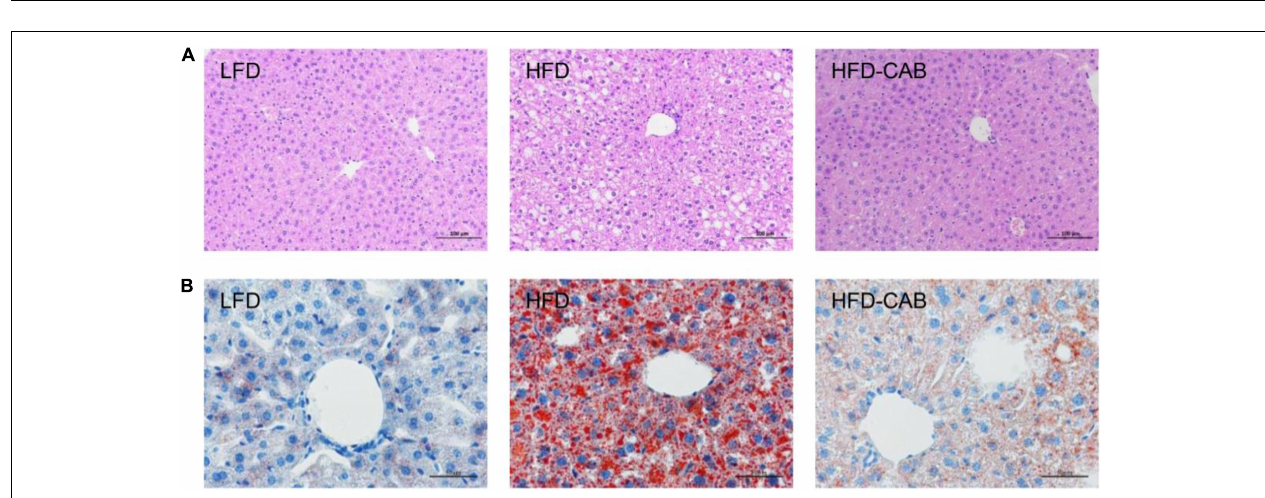
FIGURE 2 | Cooked adzuki bean alleviates dyslipidemia and liver injury in HFD-fed mice. (A) Serum lipid profile, and (B) Serum ALT and AST levels. Data presented as mean ± SEM, n = 7 per group. ** P < 0.01 vs. LFD; # P < 0.05 and ## P < 0.01 vs. HFD. TC total cholesterol; TG triacylglycerol; HDL-C high-density lipoprotein cholesterol; LDL-C low-density lipoprotein cholesterol; AST aspartate aminotransferase; ALT alanine aminotransferase; LFD, low-fat diet; HFD, high-fat diet; HFD-CAB, high-fat diet supplemented with cooked adzuki bean.